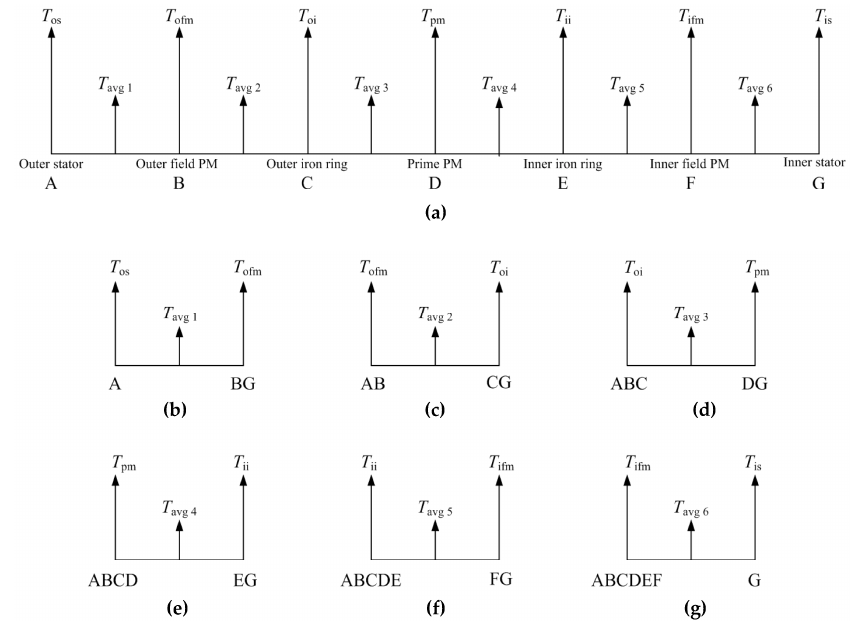
Figure 7. Torque analysis of DS-MGM: ( a ) Torque distribution between parts; ( b ) Outer stator and outer field PM; ( c ) Outer field PM and outer iron ring; ( d ) Outer iron ring and prime PM; ( e ) Prime PM and outer iron ring; ( f ) Inner iron ring and inner field PM; ( g ) Inner field PM and inner stator.